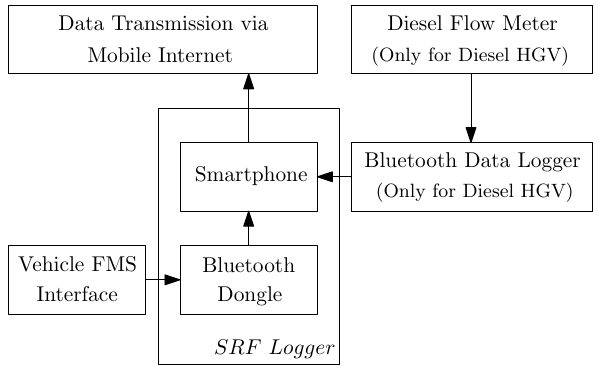
Figure 3. A block diagram of the data collection